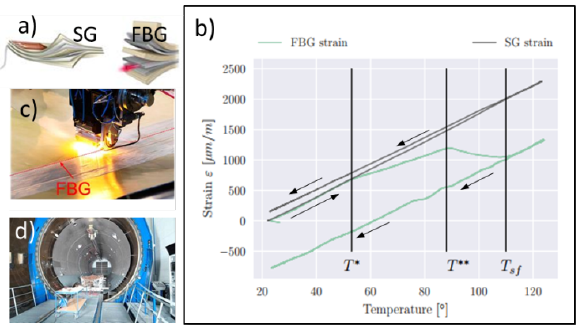
nals are shown in Figure 8b. Both signals show a linear strain-temperature relation right from the beginning.